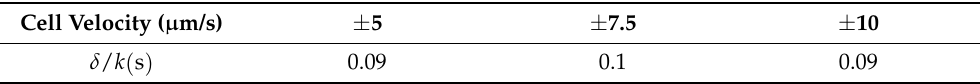
Table 1. Relationship between cell velocity and kinetic